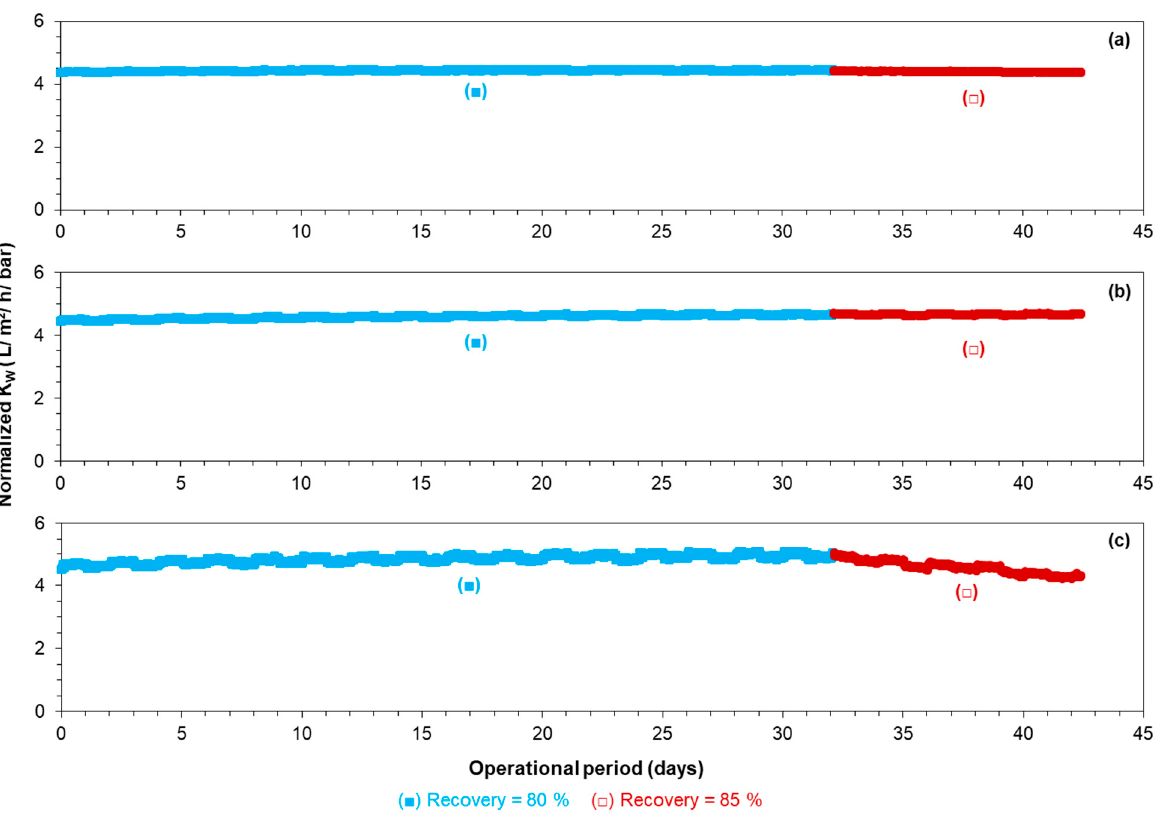
Figure 4. Average normalized permeability of the ( a ) first stage, ( b ) second stage, and ( c ) third stage of the RO unit at 80 and 85% recoveries without antiscalant addition.